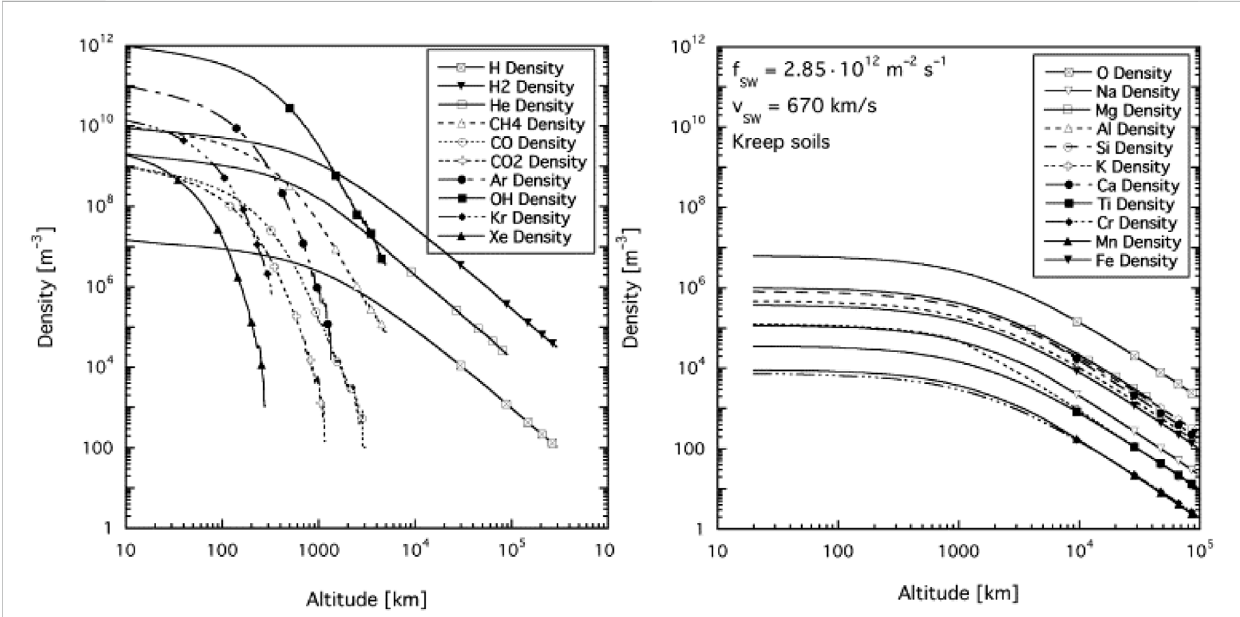
FIGURE 9 Left: Lunar exosphere density pro fi les for the atoms and molecules thermally released from the surface; based on the exospheric surface densities from Stern (1999). Right: Lunar exosphere density pro fi les for the atoms released through sputtering. Both calculations are done for the sub-solar point. (From: Wurz et al.,